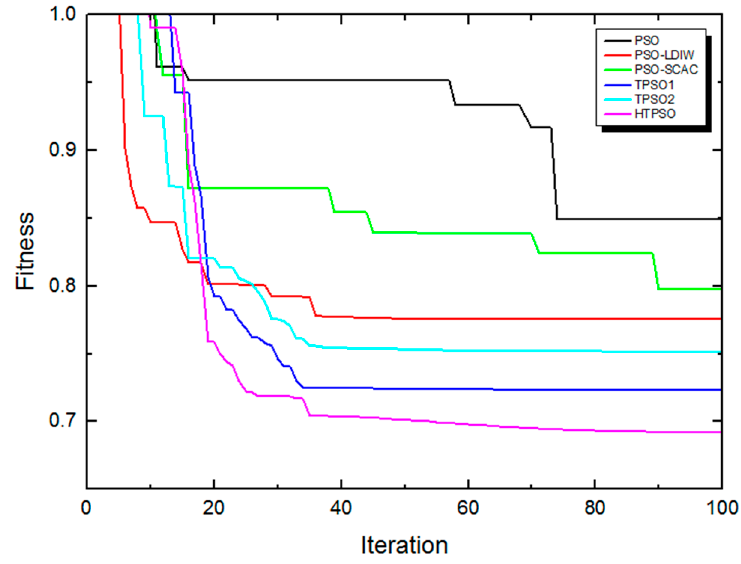
Figure 5. Fitness convergence curve. Table 7. Control variable results after optimization of different